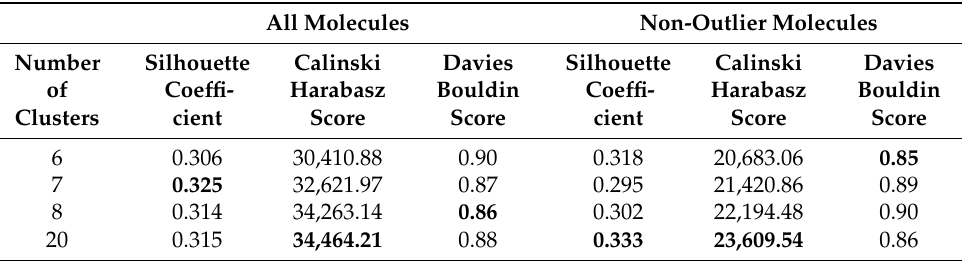
Table 5. Clustering quality metrics suggest well-defined clusters at each selected number of clusters. Clustering quality metrics were calculated for each number of clusters evaluated in the UMAP algorithm. Non-outlier molecules were retrieved at an outlier cutoff of 0.5. The best value for each metric for either all molecules or non-outlier molecules is highlighted in bold. For readability, clustering quality results were rounded to either two or three decimal places.